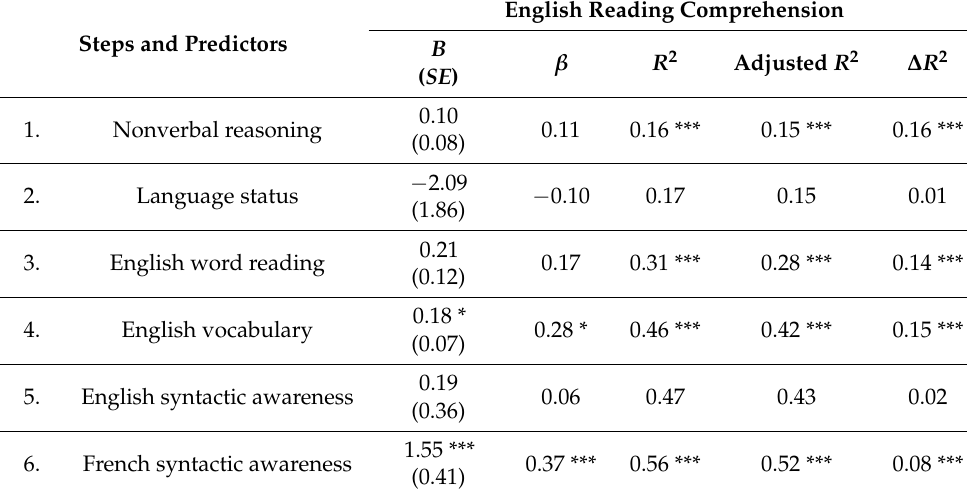
Table 4. Hierarchical Linear Regression Predicting Grade 3 English Reading